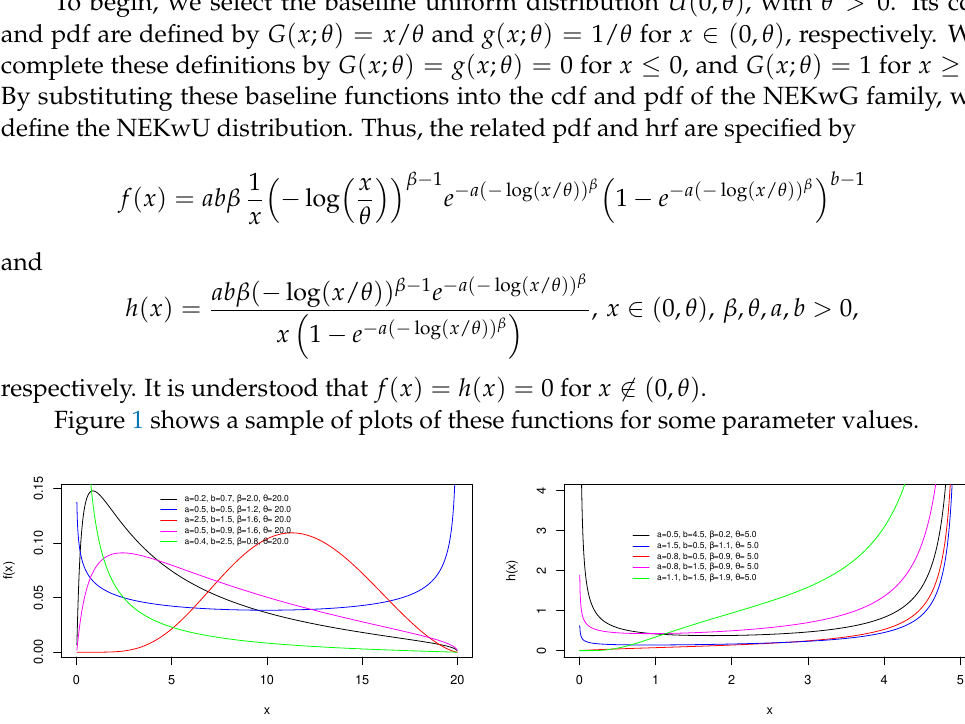
Figure 1. Sample of plots of ( left ) the pdf and ( right ) the hrf of the NEKwU